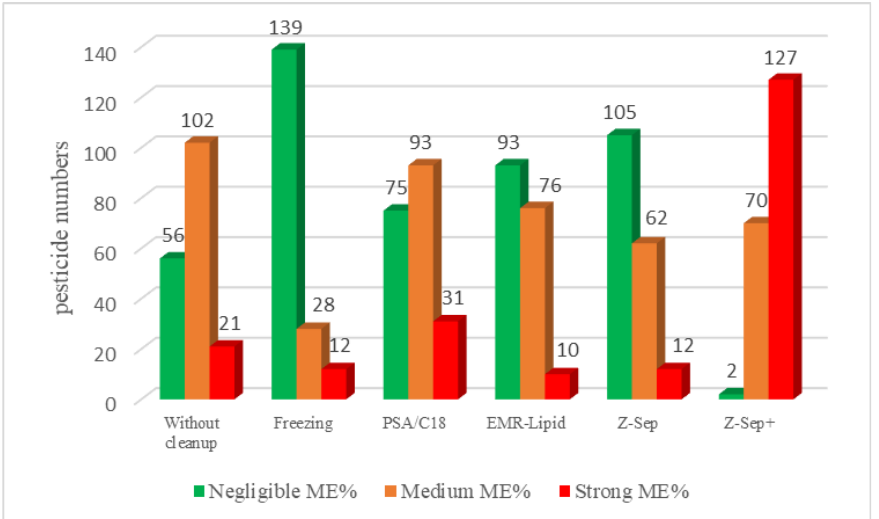
Figure 4. Matrix effect of pesticides in rapeseeds depending on the different purification sorbents.